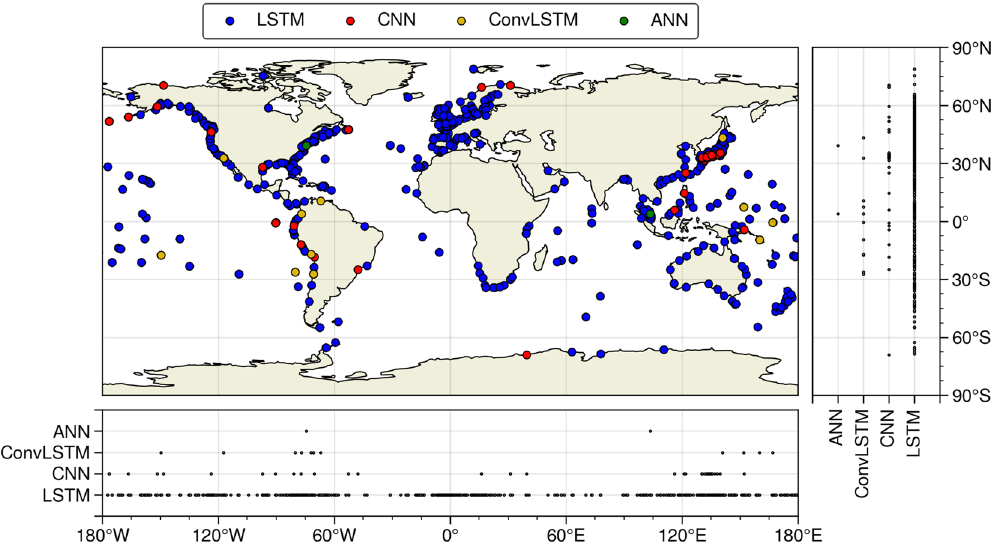
Figure 4. NN model type from the highest CRPSS value shown in Fig. 3. For readability, we display the models in the following order LSTM → CNN → ConvLSTM →